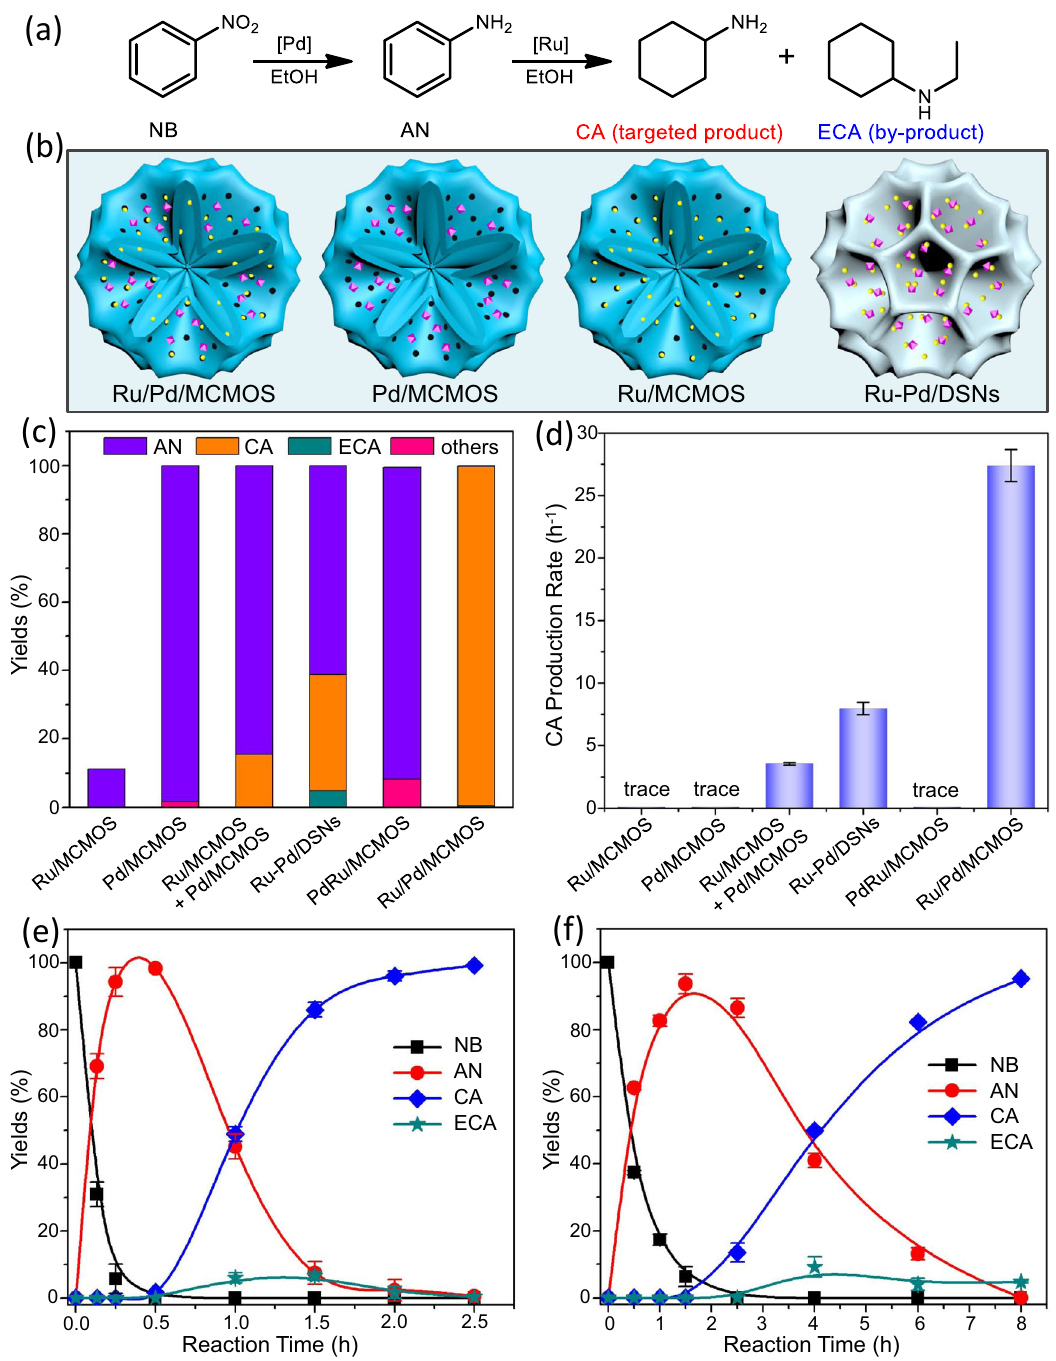
Fig. 3 Catalytic performances evaluation. a Reaction network of the sequential hydrogenation of nitrobenzene. b Schematic illustration of four catalysts including Ru/Pd/MCMOS, Pd/MCMOS, Ru/MCMOS and Ru-Pd/DSNs. c Product distributions of the sequential hydrogenation over different catalysts. d The CA production rate over different catalysts. The production rate value is estimated according to the CA yield of 20 – 30%. e Kinetic plots of the sequential hydrogenation over Ru/Pd/MCMOS. f Kinetic plots of the sequential hydrogenation over the physically mixed catalyst. Reaction conditions: NB (0.25 mmol), solid catalyst (Ru 0.77 mol%, Pd 1.01 mol%), ethanol (2.0 mL), H 2 (2.0 MPa), 80 °C, 2.5